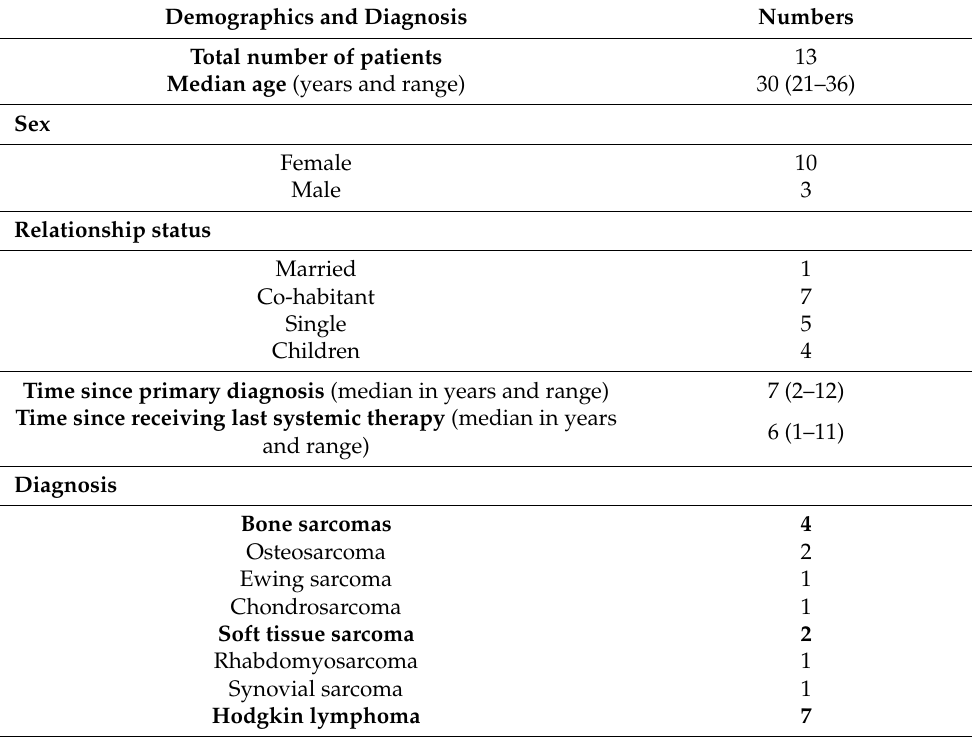
Table 1. Baseline demographic and clinical